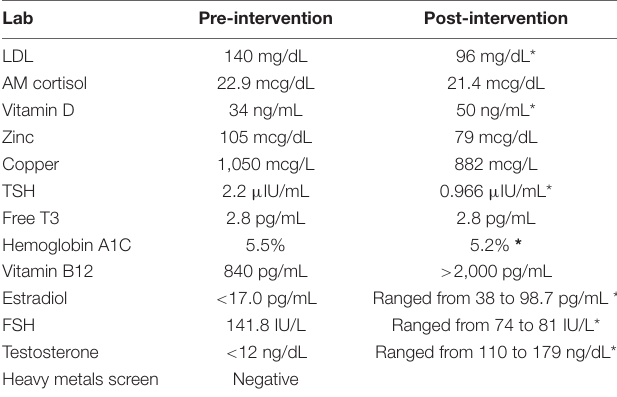
TABLE 3 | Comparison of pre- vs. post-intervention serum laboratory values for Ms.